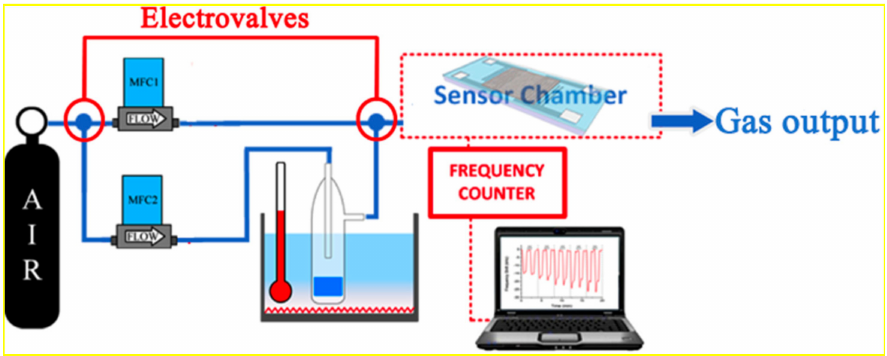
Figure 2. Experimental setup used to measure different concentrations of solvents in real